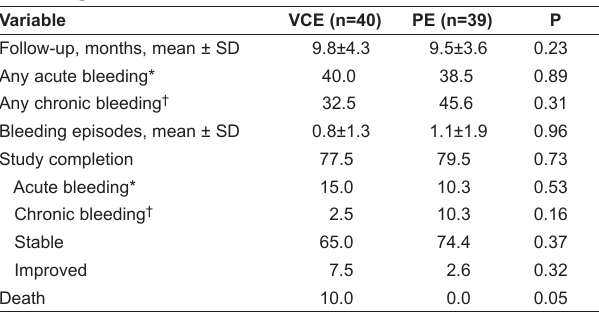
TABLE 3 Bleeding rates